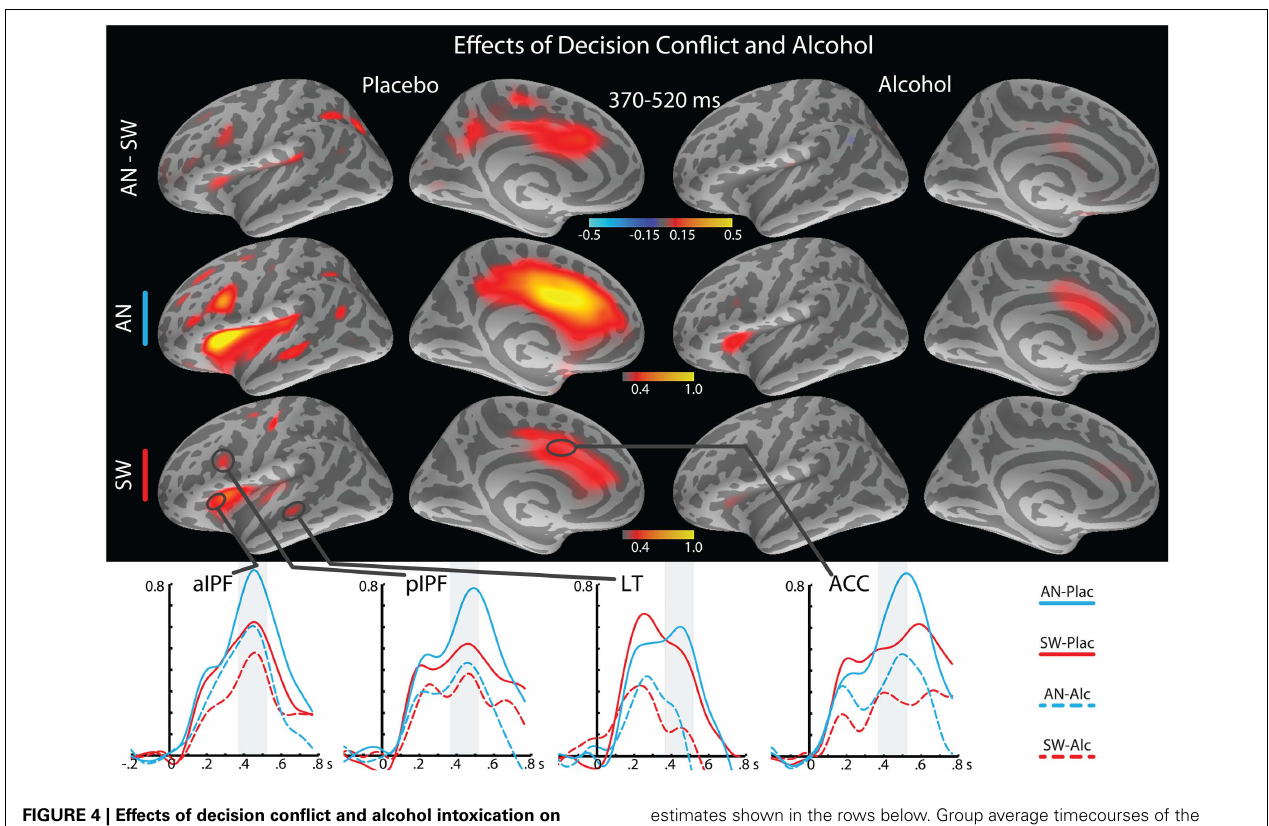
FIGURE 4 | Effects of decision conflict and alcohol intoxication on theta power estimates in the 370–520ms time-window under placebo (left) and alcohol (right), with lateral and medial views of the left hemisphere. The top row shows the AN–SW group average subtraction, with the overall event-related theta group average